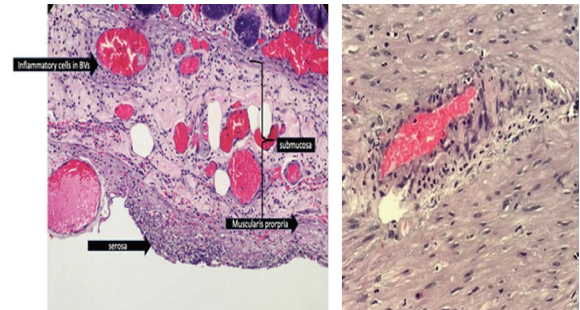
Figure 5: Blood vessel infltrated with acute infammatory cells and areas in the subserosa with possible microthrombi and beginning thrombus formation.